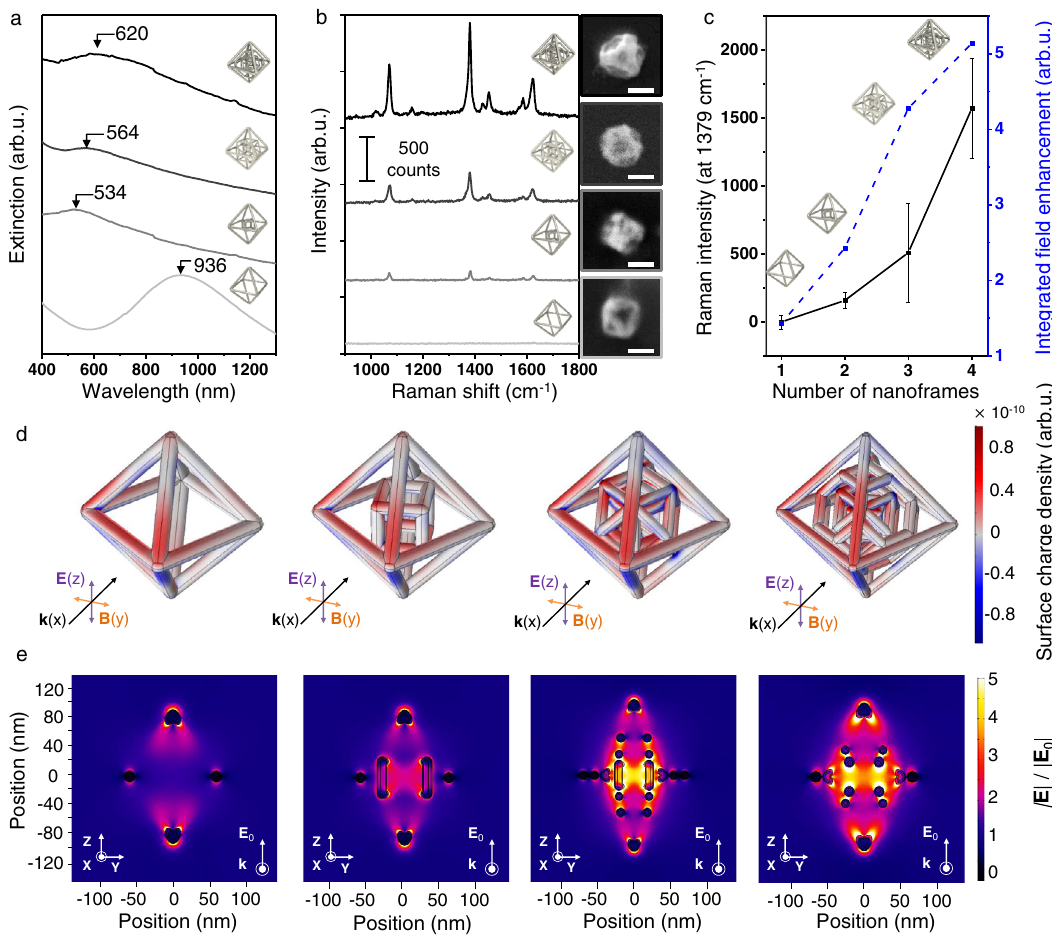
Fig. 5 | Investigating the optical properties of complex Ag nanoframes with varying the number of nanoframes. a LSPR band pro fi le of 1 st , 2 nd , 3 rd , and 4 th Ag nanoframes, b representative single-particleRamansignalsof1 st ,2 nd ,3 rd ,and4 th Ag nanoframes originating from their corresponding SEM images (scale bar = 200nm), c plotted data of single-particle Raman intensity (at 1379cm − 1 ) and the- oretically calculated values of electric near- fi eld enhancement as function of the